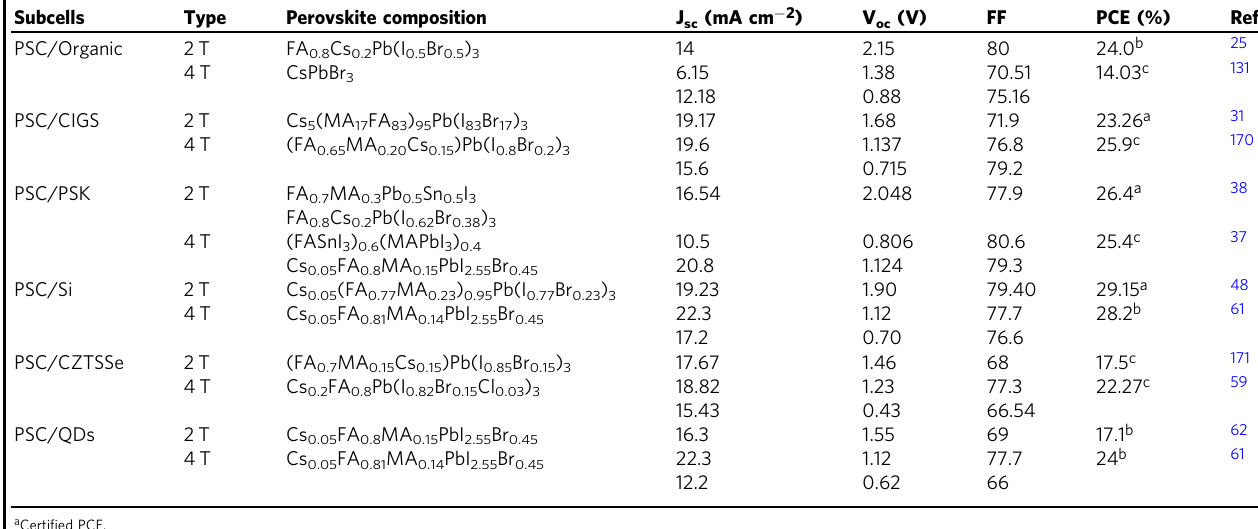
Table 1 The best-performing perovskite-based tandem solar cells. Subcells